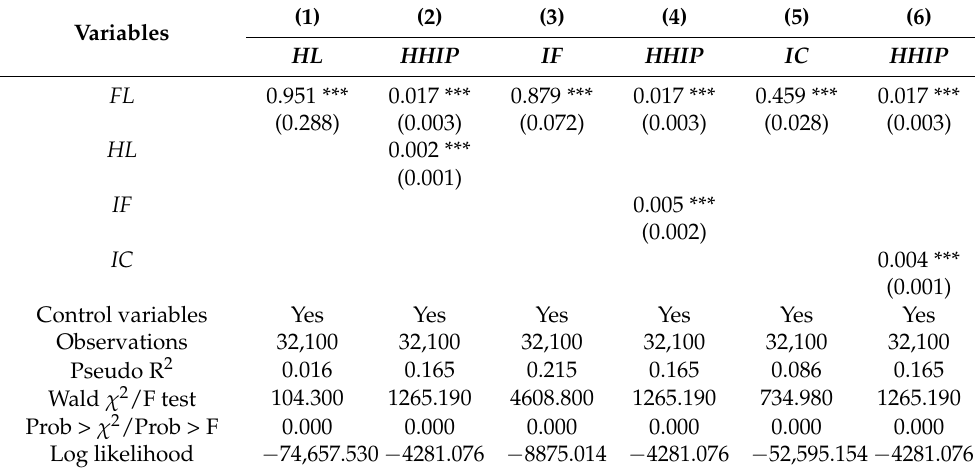
Table 10. Mediating effects of financial literacy on household health